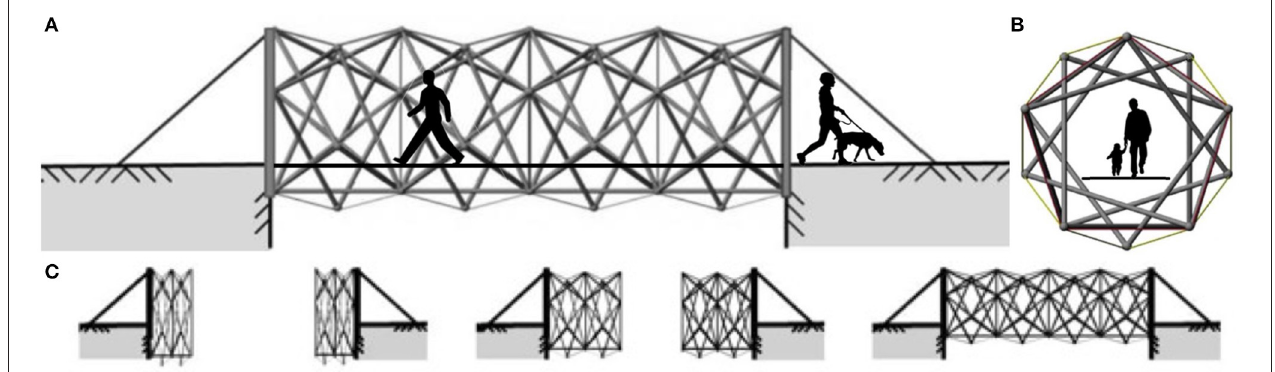
FIGURE 1 | Side (A) and front (B) views of tensegrity footbridge. Deployment of the structure (C) is shown in three stages.